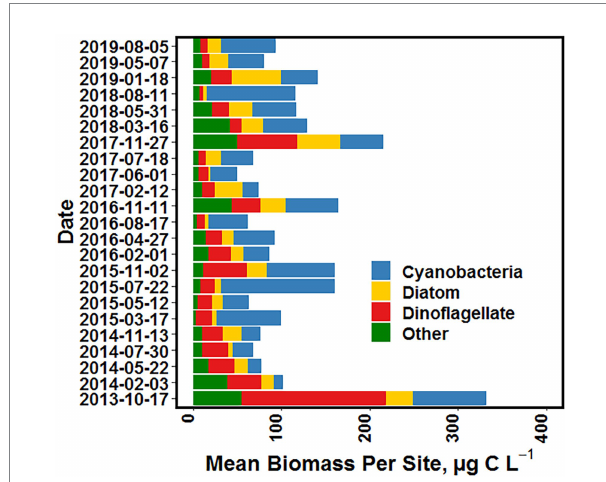
FIGURE 14 Mean surface water phytoplankton biomass ( μ g carbon L − 1 ) for each sampling date, sub-divided into four major groups, i.e., cyanobacteria, diatoms, dinoflagellates and all “other” (i.e., all other taxa) groups, from October 2013 to August 2019.